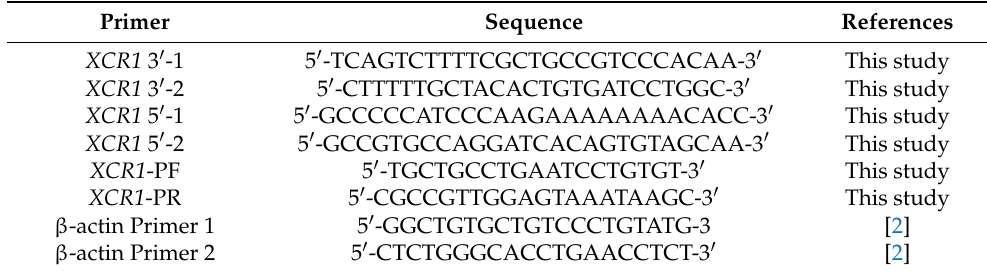
Table 1. Primers for XCR1 gene amplification and their qRT-PCR analysis. Primer